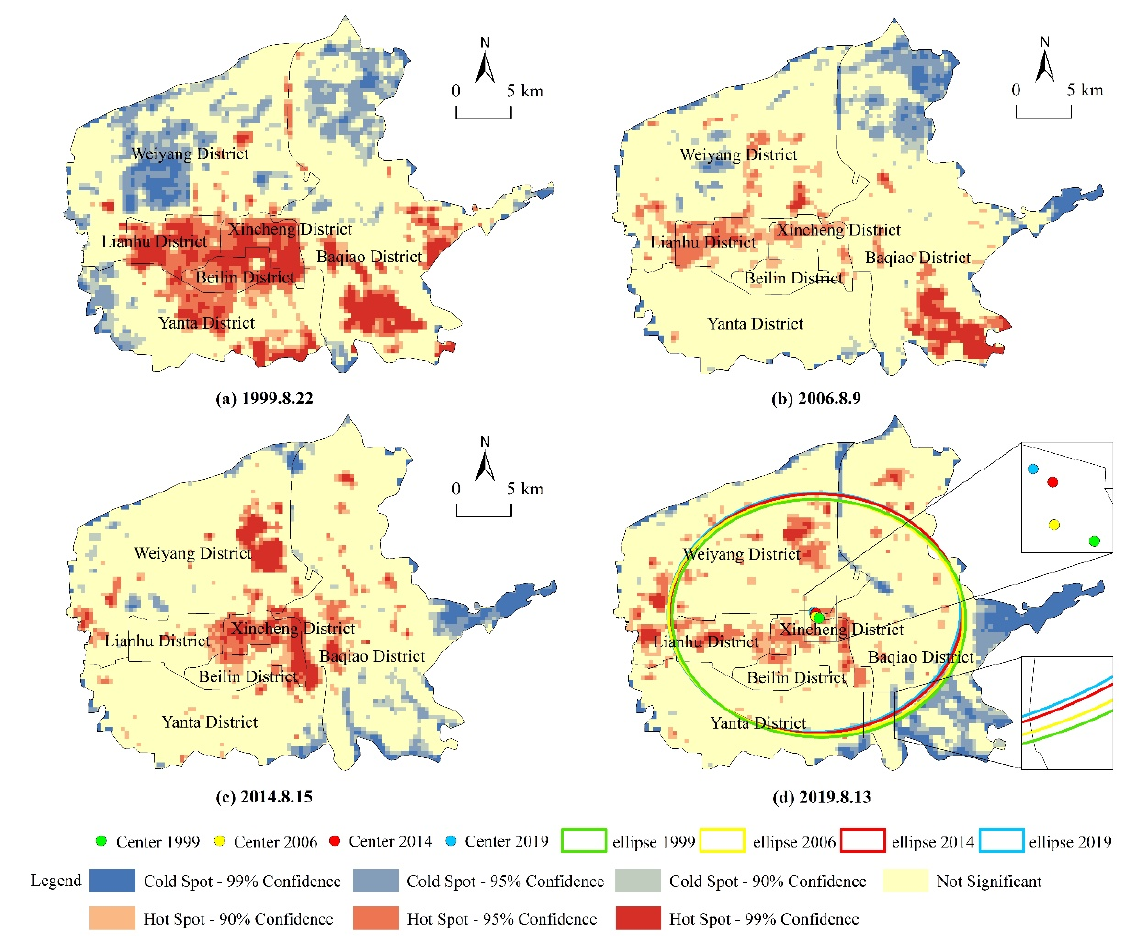
Figure 4. Migration of hot–cold spots, standard deviation ellipse, and gravity center of UHI.